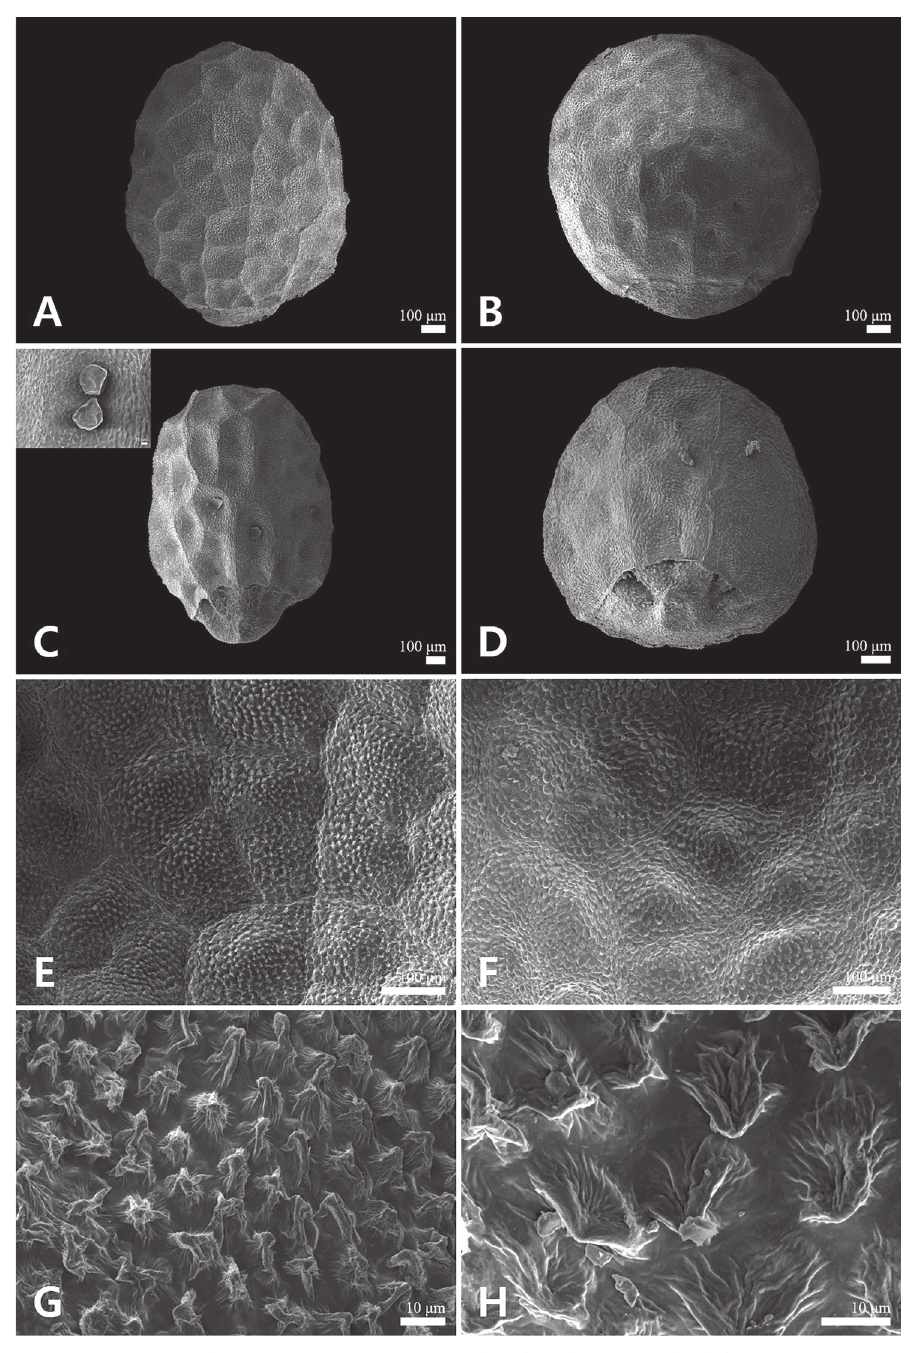
Figure 3. Scanning electron microscope micrographs of nutlets in Mosla dadoensis ( A, C, E, G ) and M. chinensis ( B, D, F, H ) A, B abaxial C, D adaxial ( C small picture showing gland) E, F primary sculpture pattern G, H secondary sculpture pattern